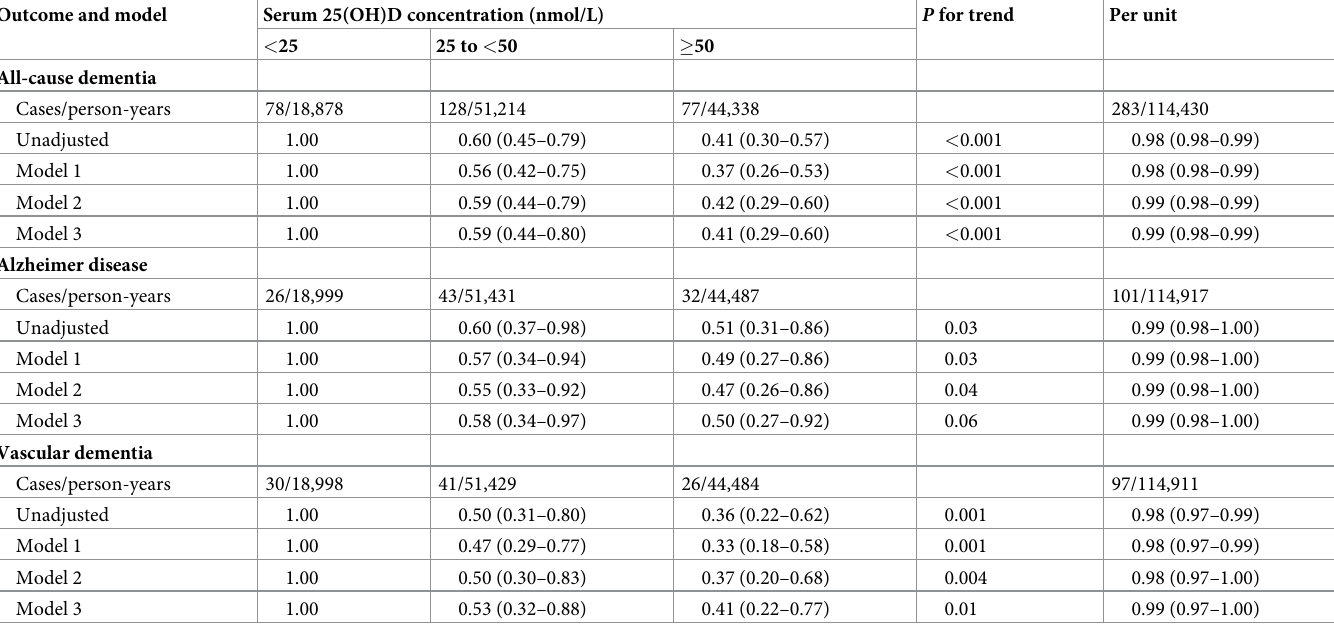
Table 2. Hazard ratios (95% confidence intervals) for all-cause dementia, Alzheimer disease, and vascular dementia according to serum 25-hydroxyvitamin D (25 [OH]D) concentration among individuals with type 2 diabetes who were � 60 years old. Outcome and